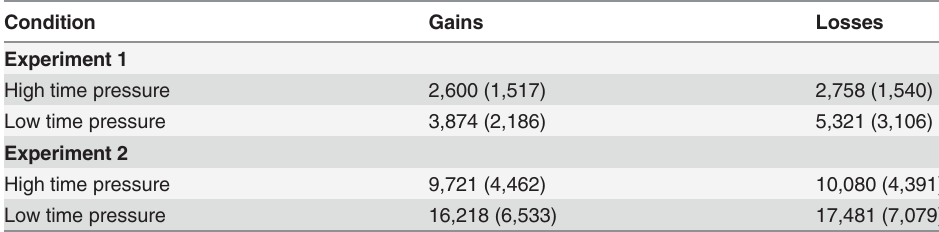
Table 3. Response times